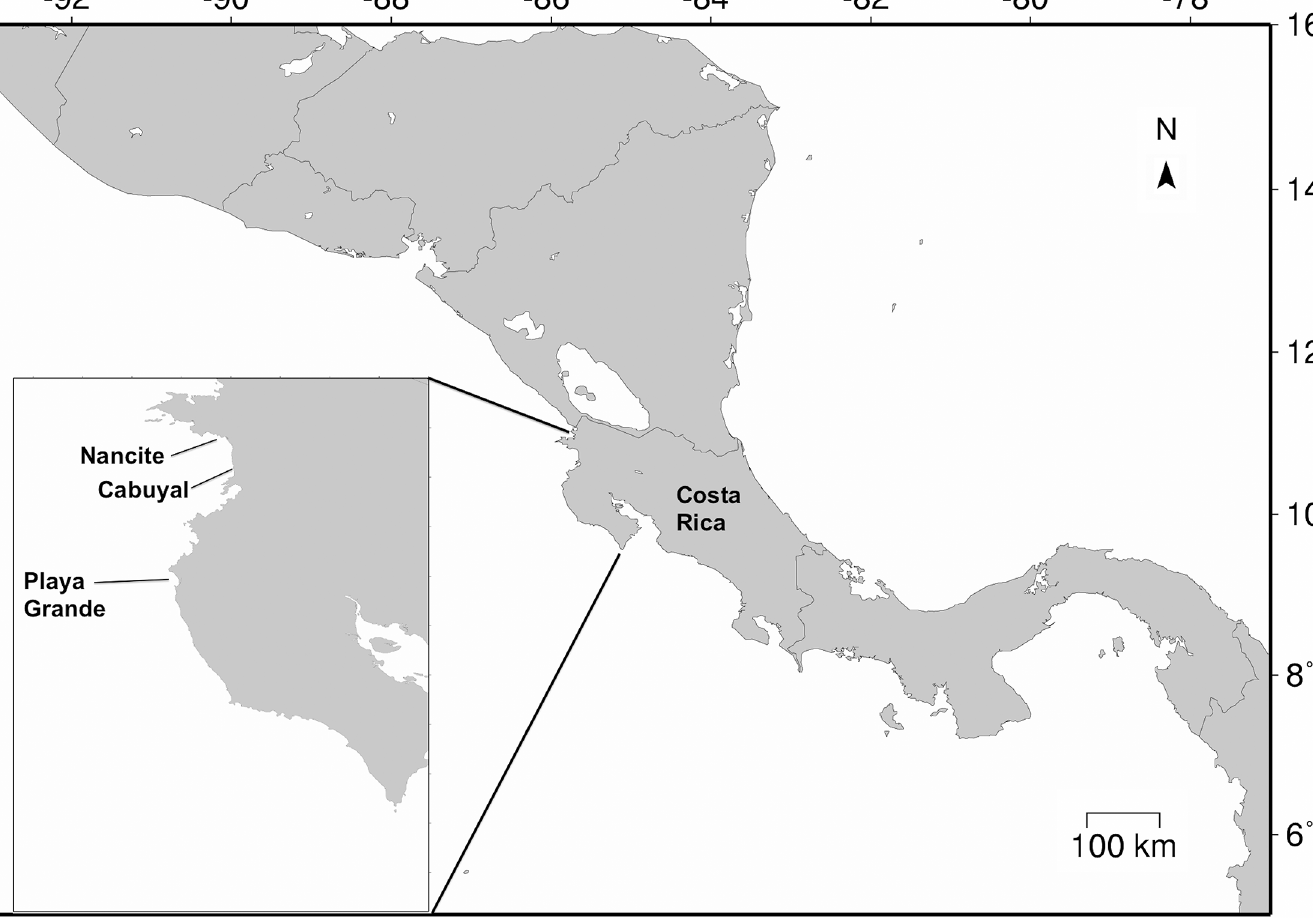
PLOS ONE | https://doi.org/10.1371/journal.pone.0177256 May 18,